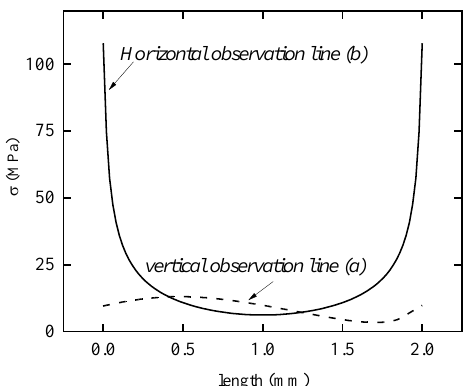
Figure 9. Stress intensity along the observation line.